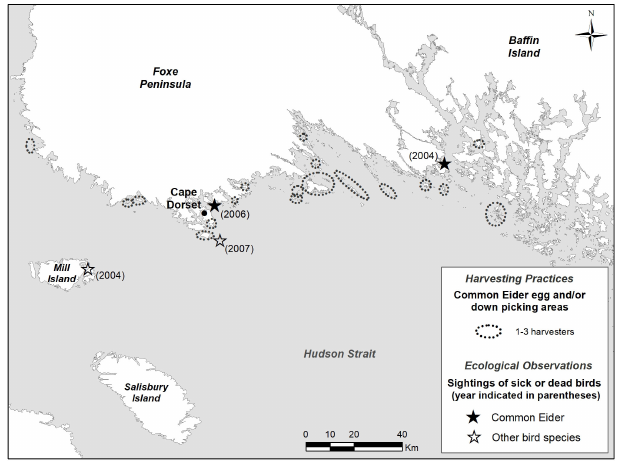
Fig. 4 . Participants’ use of the Common Eider ( Somateria mollissima ) and observations of sick or dead Common Eiders and other birds in Cape Dorset, Nunavut.